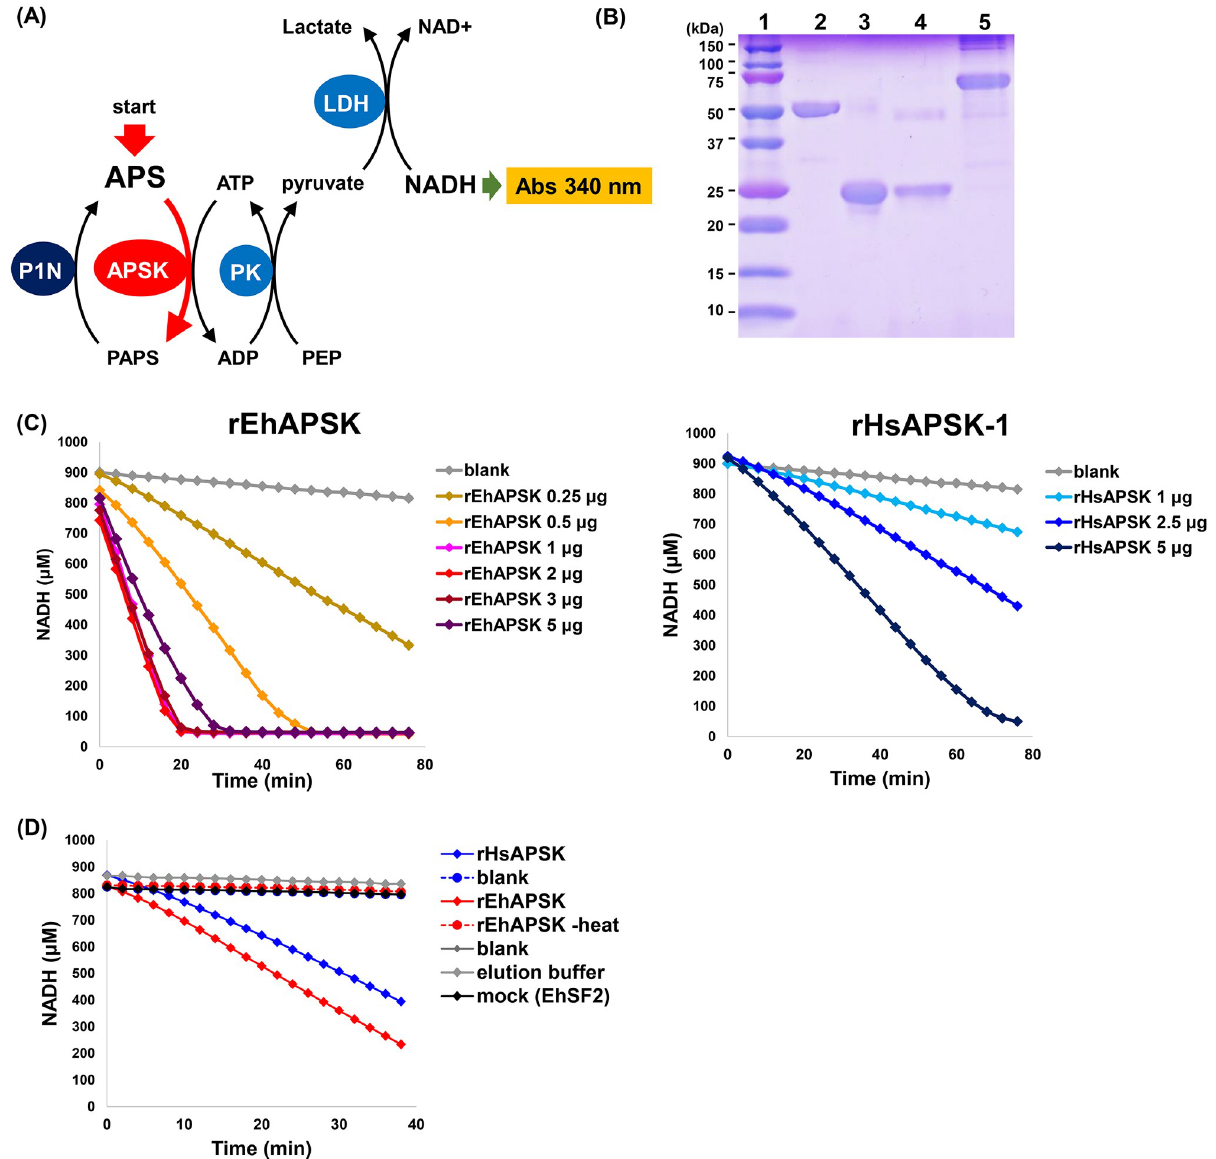
Fig 2. Establishment of the in vitro 96-well plate-based APSK activity assay. (A) Schematic illustration of the coupling assay to measure APSK activity. APS, adenosine 5 0 -phosphosulfate; APSK, APS kinase; PAPS, 3 0 -phosphoadenosine 5 0 -phosphosulfate; NP1, nuclease P1; PK, pyruvate kinase; PEP, phosphoenolpyruvate; and LDH, lactate dehydrogenase. (B) SDS-PAGE of the affinity-purified recombinant proteins. Lane 1, molecular weight markers; lane 2, rEhAPSK; lane 3, rHsAPSK (recombinant APSK domain of HsPAPSS1); lane 4, recombinant APSK domain of HsPAPSS2; and lane 5, recombinant HsPAPSS1 (full-length HsPAPSS1). (C) Dose-dependent effect of rEhAPSK and rHsAPSK on APSK activity. (D) Validation of screening system for APSK inhibitors.